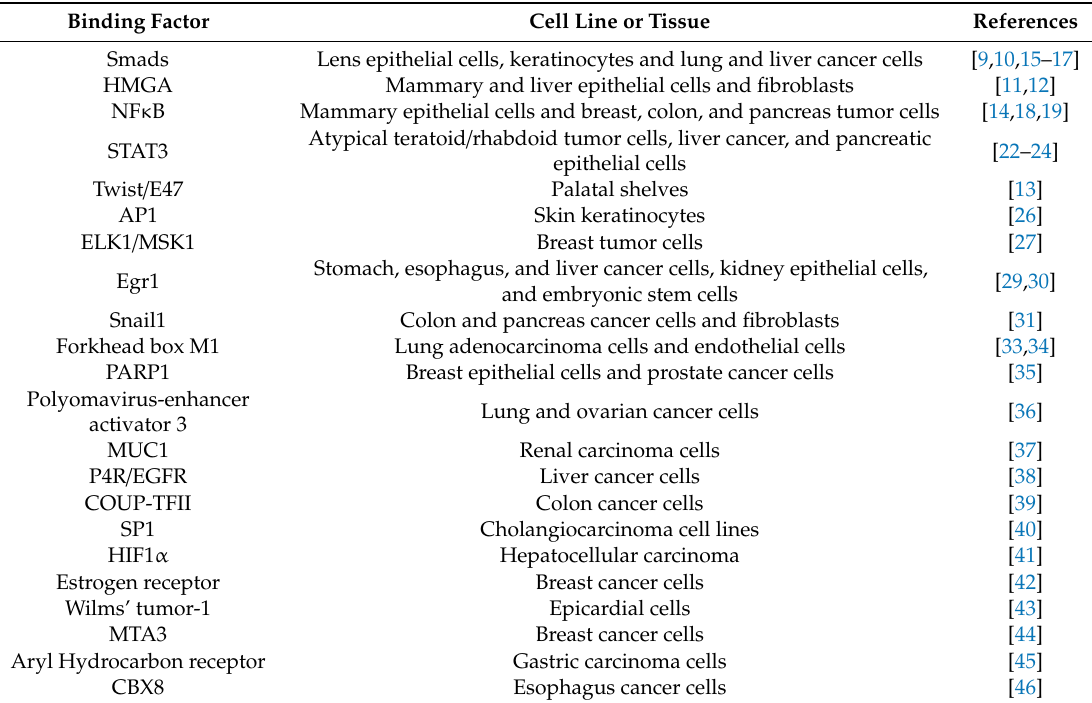
Table 1. Transcription factors binding to the Snai1 or SNAI1